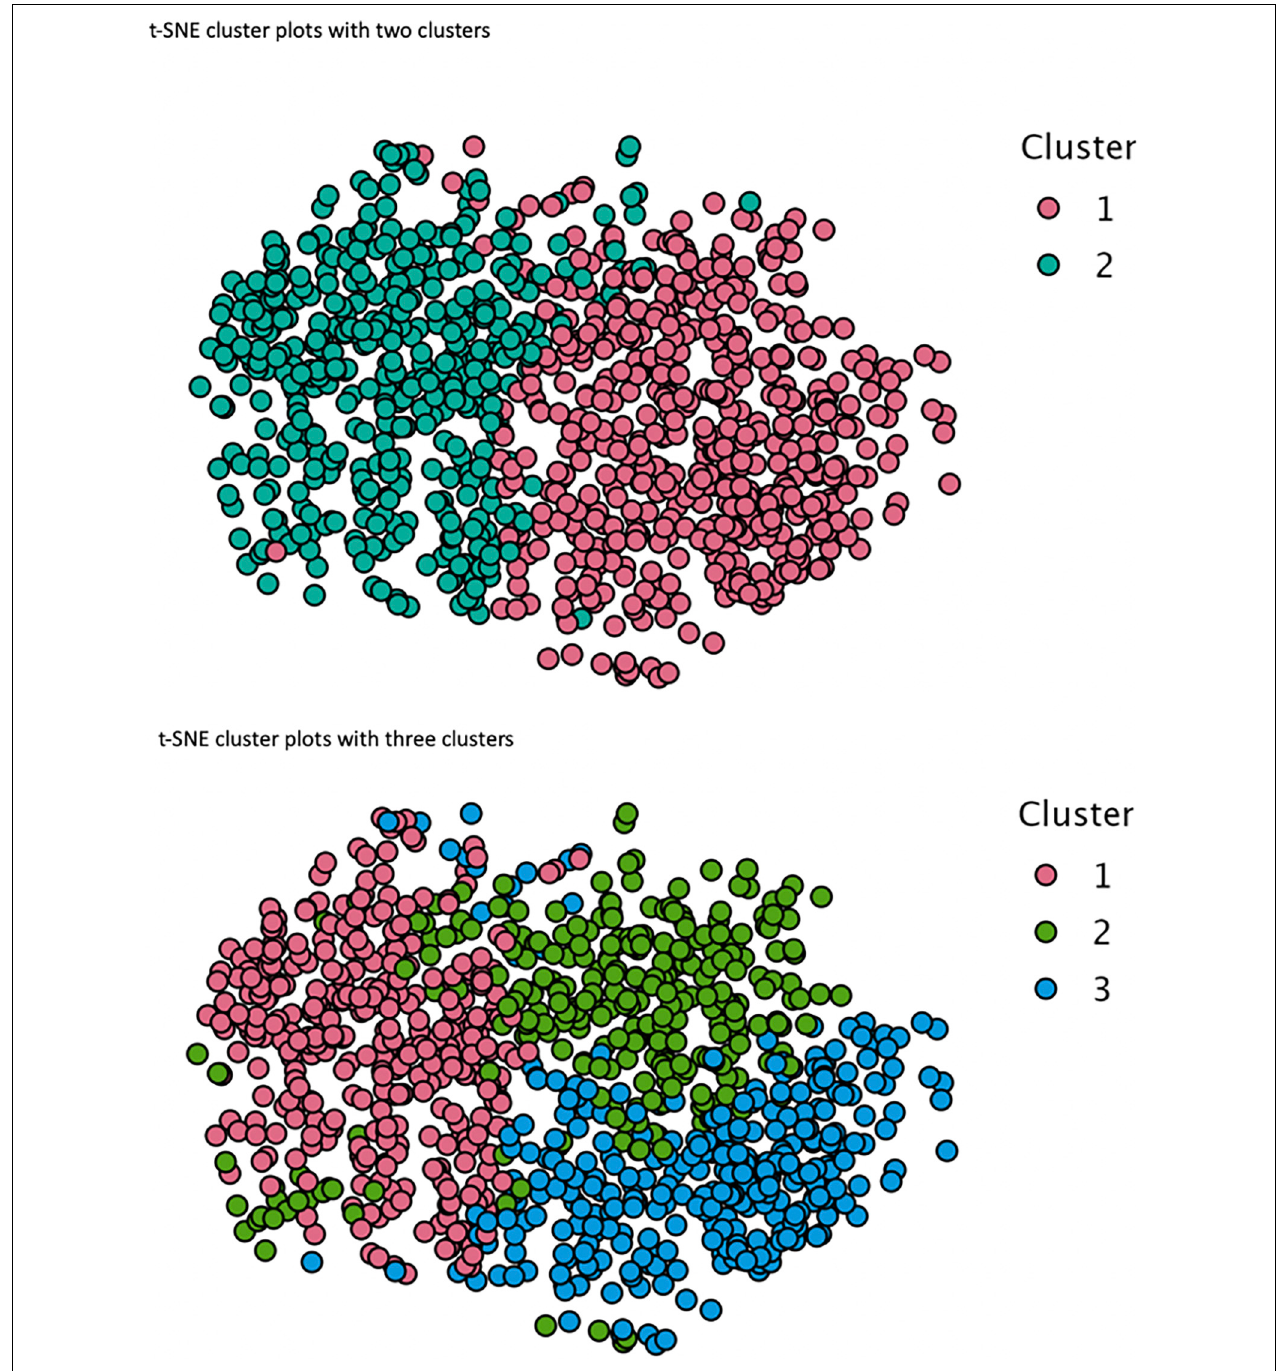
FIGURE 3 | t-SNE cluster plots for two and three